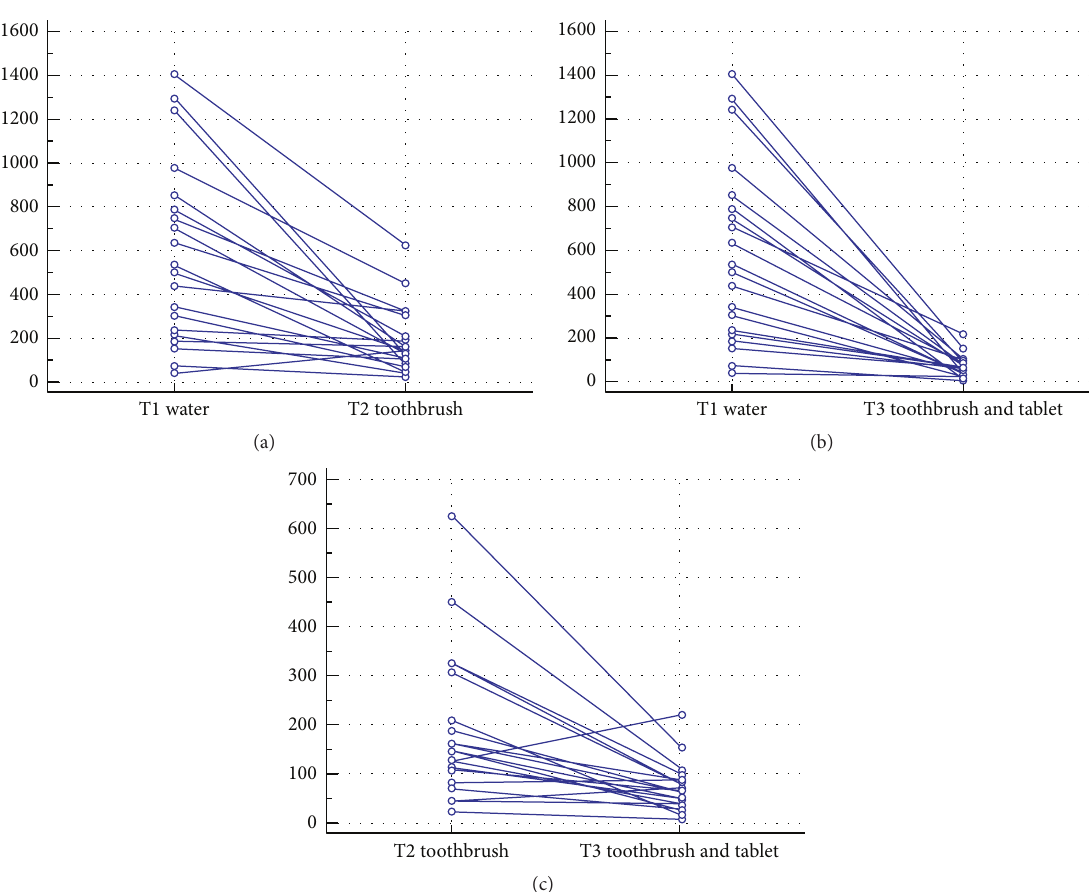
Figure 3: Wilcoxon test for paired data. W and TB (a), W and TBT (b), and TB and TBT